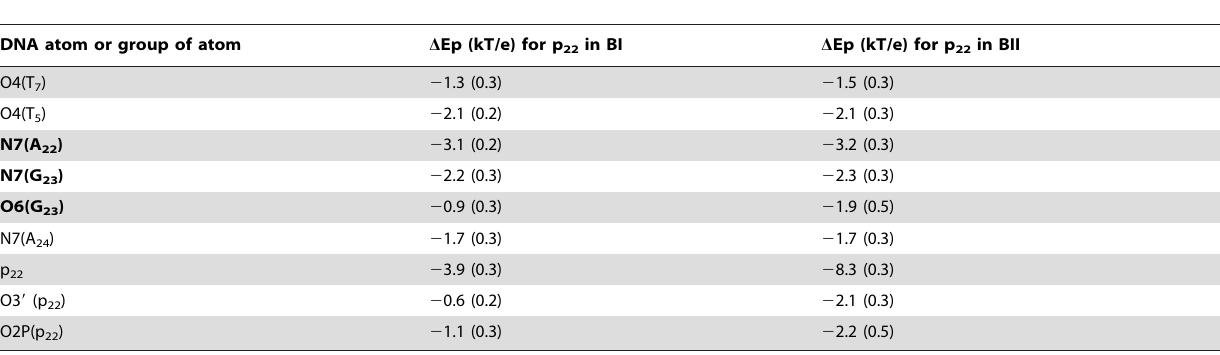
D Ep represents the electrostatic effect of Mg 2 + on various DNA atoms or groups of atoms. Mg 2 + binds to A 22 and G 23 (in bold) in the C 21 p 22 A 22 p 23 G 23 p 24 A 24 fragment. D Ep values were calculated for p 22 either in BI ( e - f ,2 50 u ) or BII ( e - f . 75 u ). T 7 and T 5 are the partners of A 22 and A 24 , respectively. The phosphate group p 22 is comprised of six atoms, O3 9 , O1P, P, O2P and O5 9 . A total of 90 snapshots extracted from S1 were examined. Standard deviations are given in parentheses.